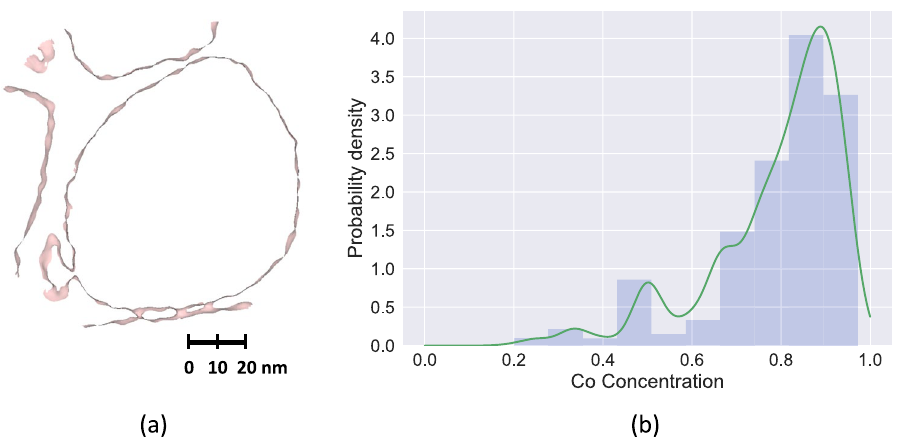
Figure 5. Comparison of iso-concentration interface generated by using IVAS software and the HED-generated interfaces. ( a ) Slice of the iso-concentration surface (Co = 0.855) along the X-axis obtained by using IVAS, ( b ) histogram of the concentrations at the pixels corresponding to the edge detected map shown in Fig. 4(a) (peak at Co =